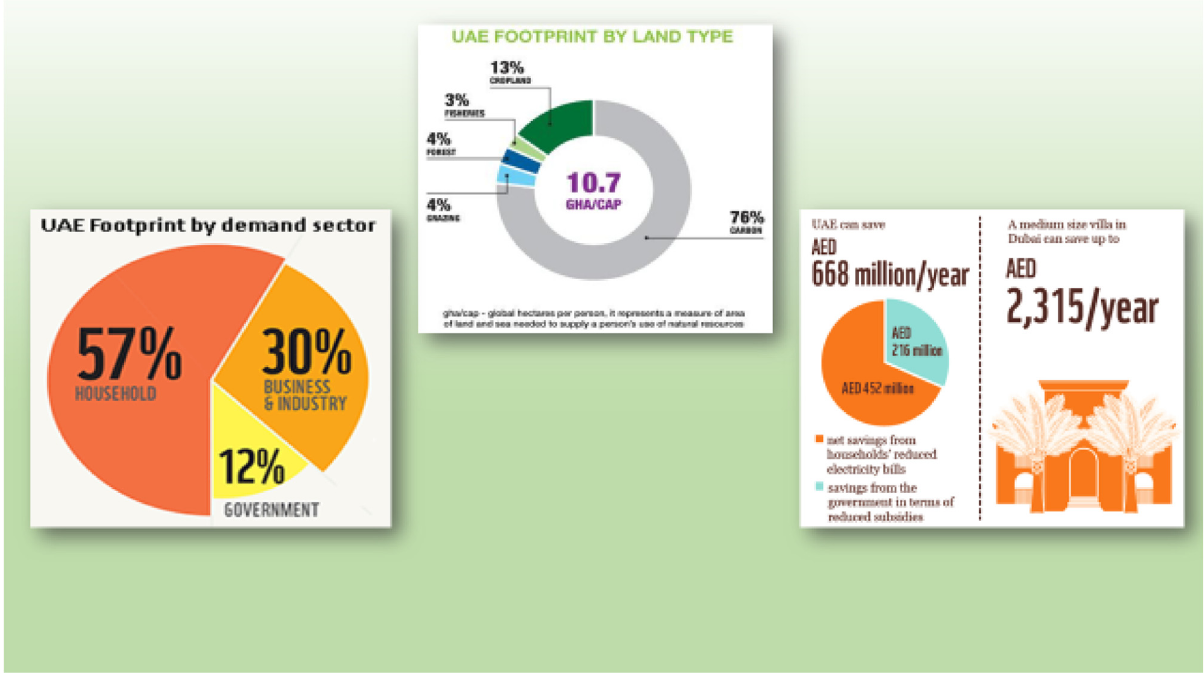
Fig. 15. UAE footprint by demand and land sectors [17 –